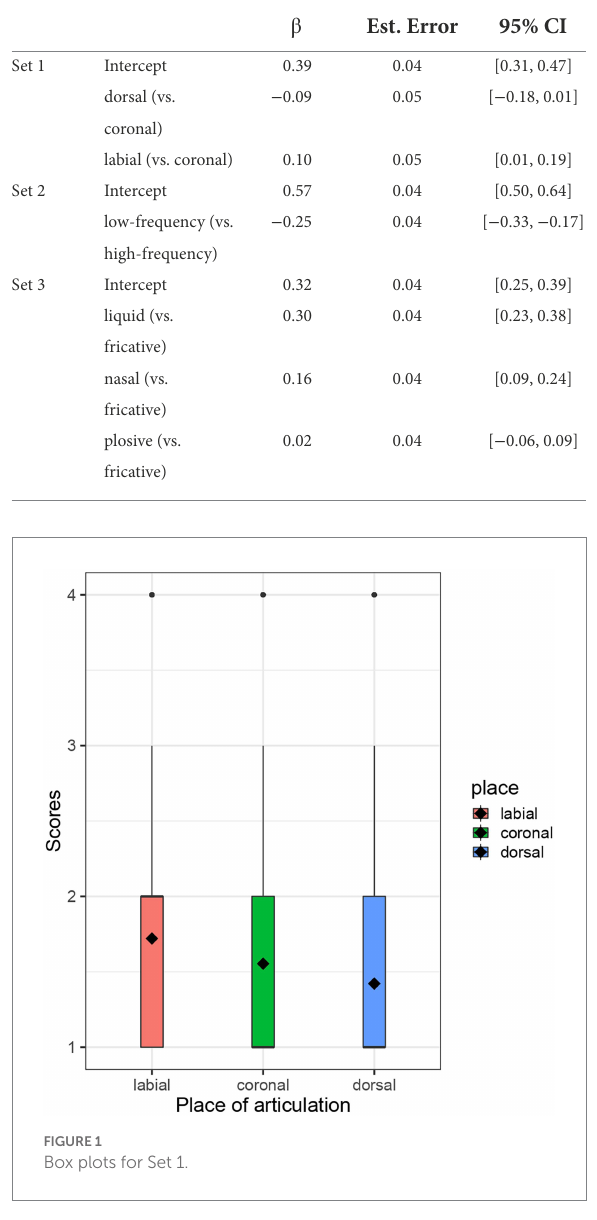
FIGURE 1 Box plots for Set 1.